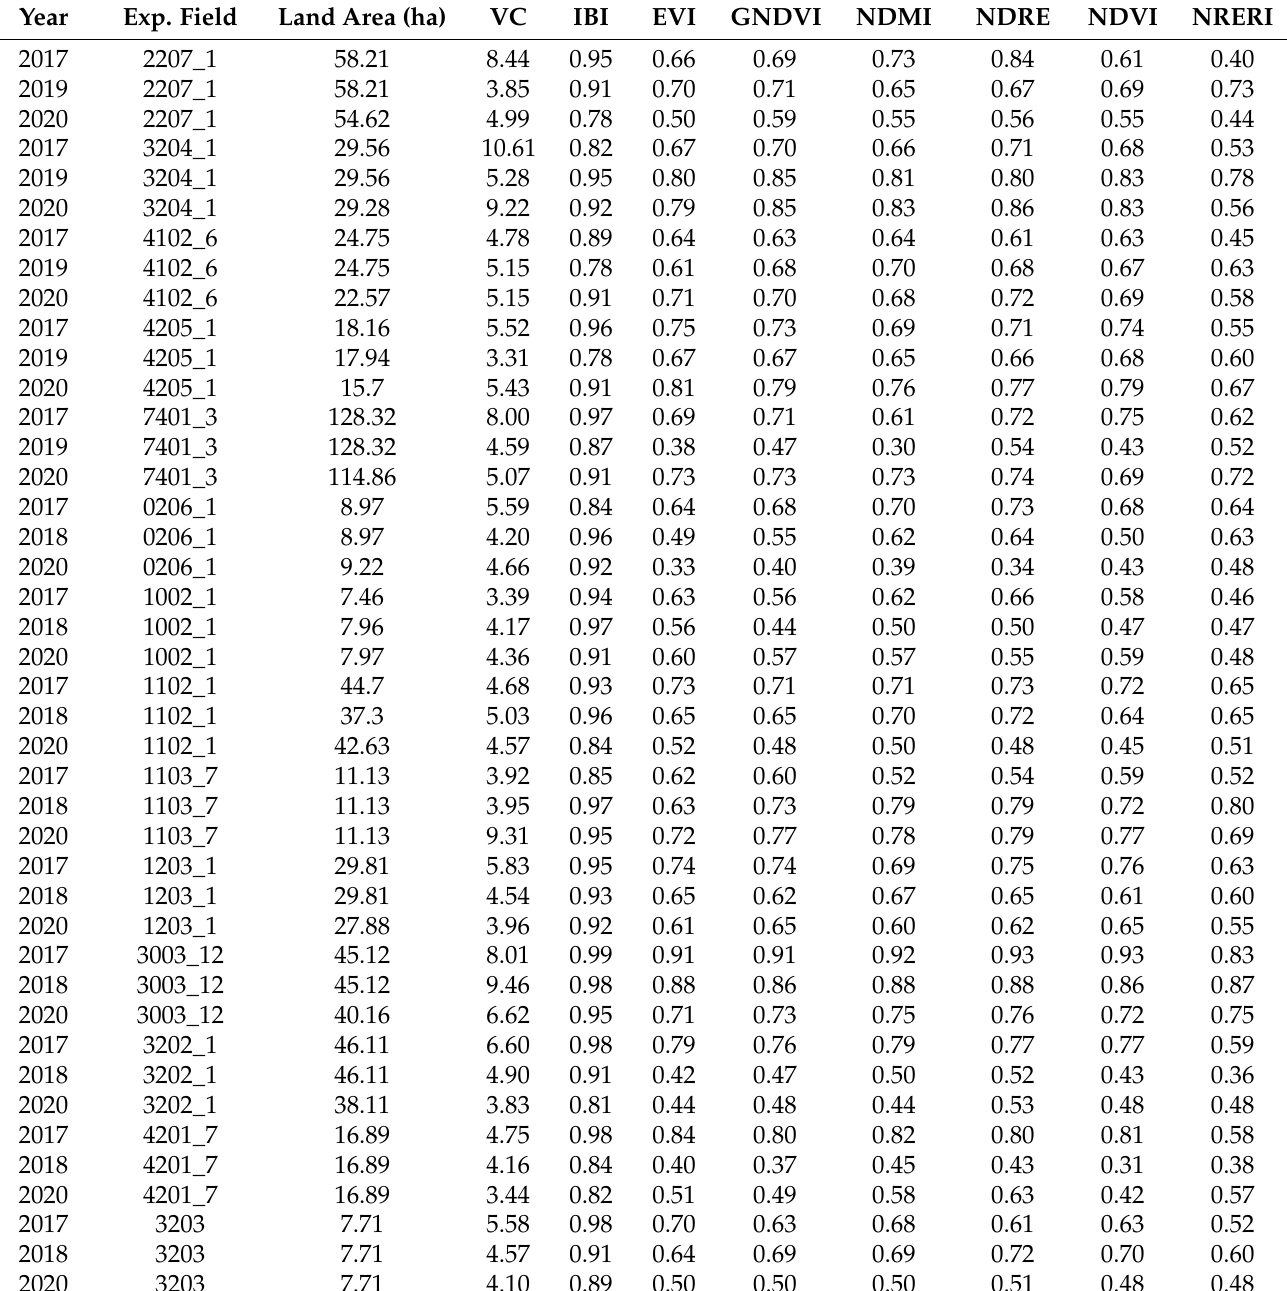
Legend: VC = variance coefficient. Significant values are indicated by red